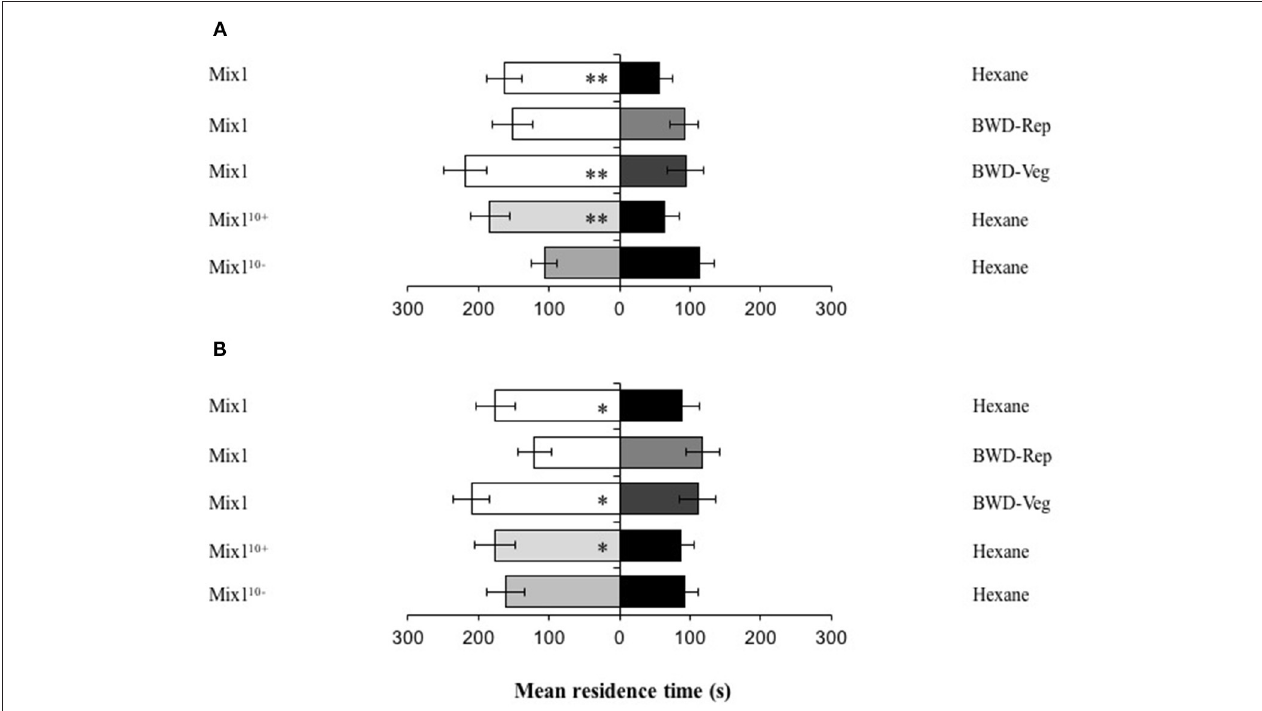
FIGURE 5 | Mean residence time in seconds of male (A) and female (B) boll weevils, Anthonomus grandis , in a Y-tube olfactometer. Mix1 = synthetic blend at the same concentration and ratio as in volatile samples collected from boll weevil-damaged cotton plants at the reproductive stage; Mix1 10 + = Mix1 × 10 concentrated; Mix1 10 − = Mix1 × 10 diluted; BWD-Rep = volatile samples collected from boll weevil-damaged cotton plants at the reproductive stage; BWD-Veg = volatile samples collected from boll weevil-damaged cotton plants at the vegetative stage. Asterisks indicate differences (*0.05 > p > 0.01, **0.01 > p > 0.001) between pairs of treatments. Bars indicate standard